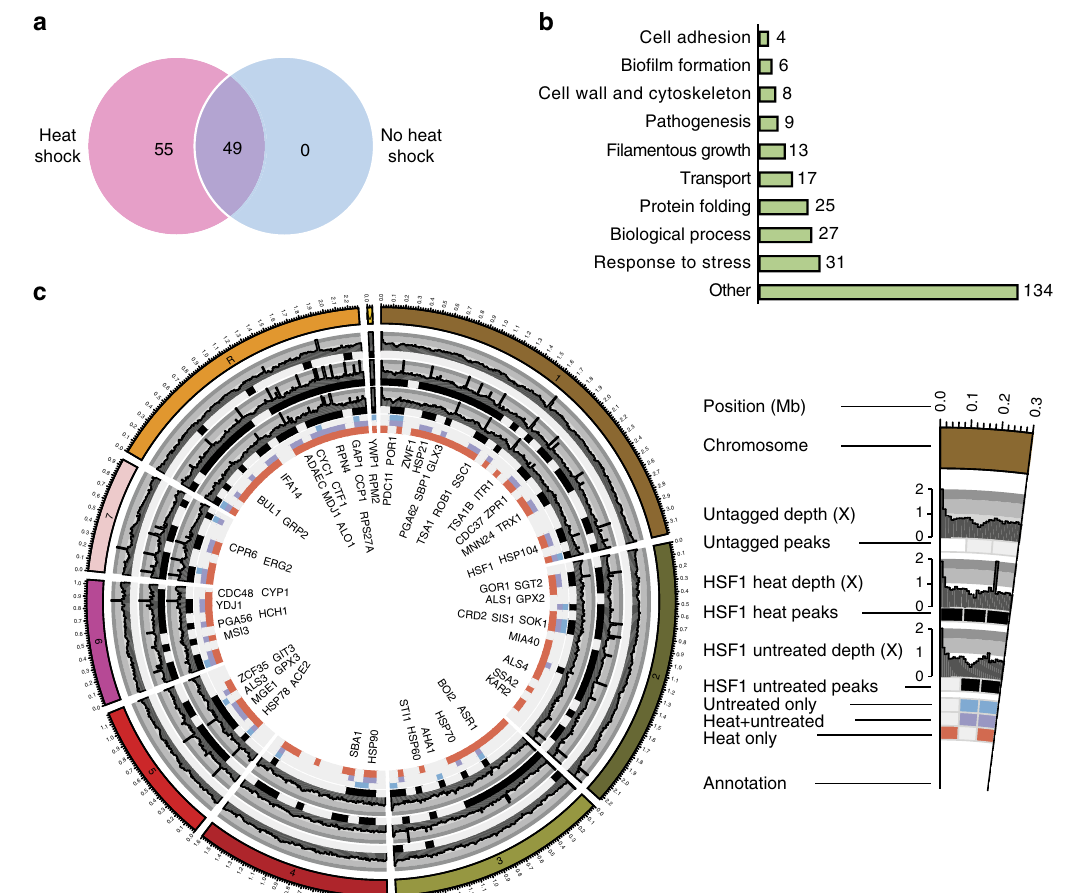
Figure 1 | Hsf1 target genes. ( a ) Venn diagram depicting number of Hsf1 peaks in the absence (no heat shock, blue) or presence (heat shock, pink) of a 30–42 (cid:2) C heat shock. ( b ) GO Slim Mapper analysis was performed on the ChIP-seq data set to identify the processes of all genes bound by Hsf1 in the absence and presence of a 30–42 (cid:2) C heat shock. Number of Hsf1 target genes represented under each category are indicated. Other categories include, but are not limited to, response to drug, cell cycle, response to chemical, organelle localization, protein catabolic process, translation, ribosome biogenesis, signal transduction and cell development. ( c ) Circos plot illustrating peaks of genes bound by Hsf1 (systematic names) in the absence and presence of a 30–42 (cid:2) C heat shock. Each circle from the periphery to the core represents the following: chromosomal location; normalized read depth of peaks from untagged samples, heat shocked samples and untreated samples; key of condition under which the peak is present (untreated, untreated with heat shock and heat shock only); and name of gene bound. All boxes represent Z 1 peak that falls within a 100kb non-overlapping